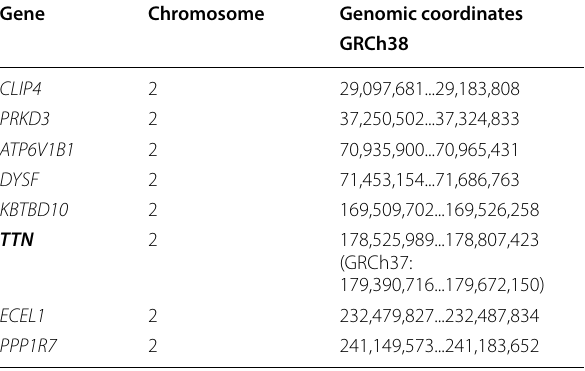
Table 4 List and genomic coordinates of the genes in the PPI network that are positioned on human chromosome